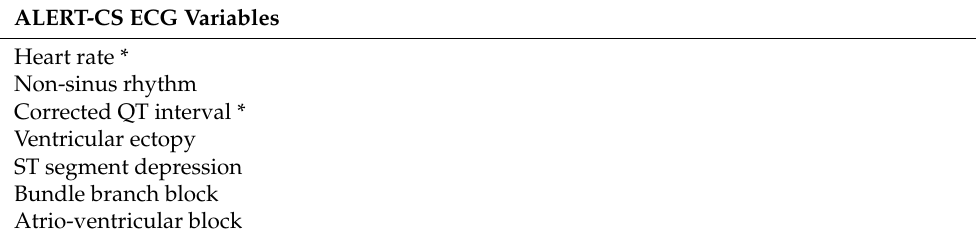
Table 3. The ECG variable predictors of cardiac syncope in patients older than 40 years in the ALERT-CS † calculator